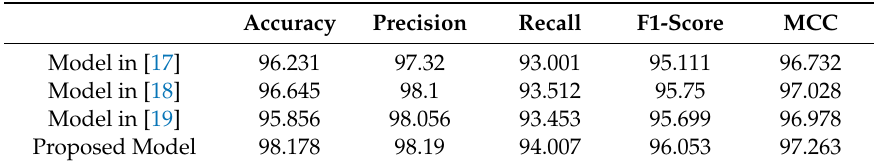
Table 8. The overall average performance of the proposed model and other comparable models presented in